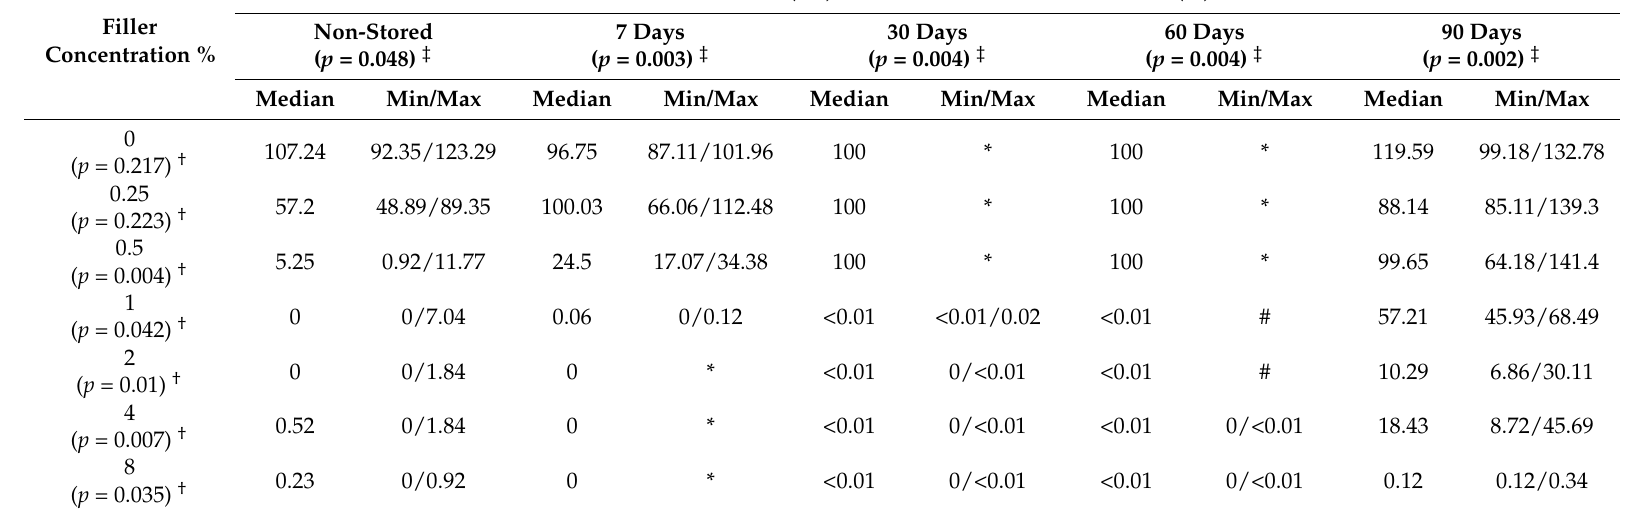
Table 1. Survival rate (SR) of Candida albicans ATCC 10231 with the PMMA resin and composites with different filler concentrations stored in distilled water and Kruskal-Wallis test results ( α =